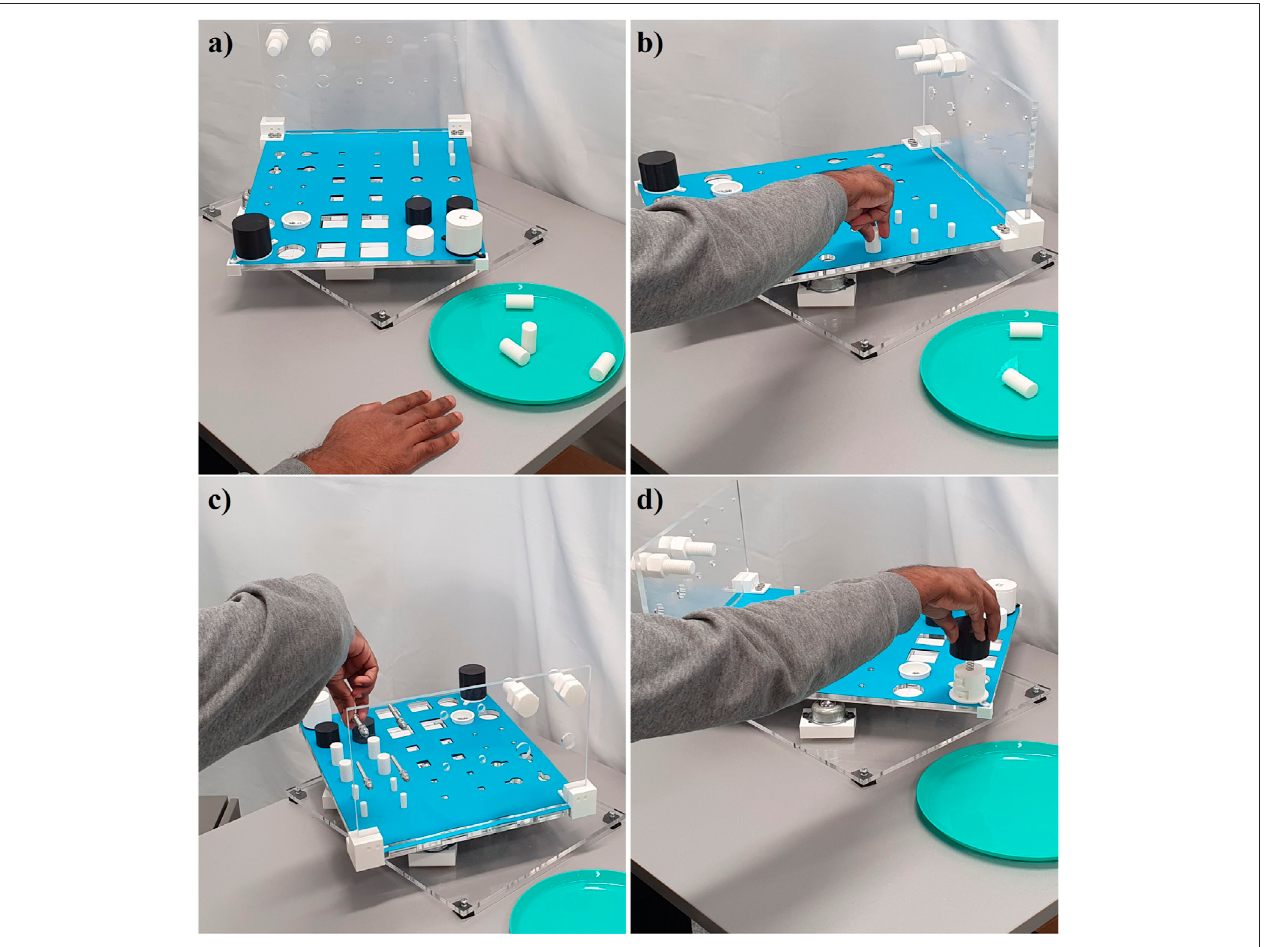
FIGURE 4 | A subject performing experiments executing tasks of the dexterity test. The sub fi gures show: (A) the initial position of the hand and objects, (B) a placingtask, (C) atool task, (D) apuzzle task. Asshown inthe images theorientationof thedexterity board constantly changesrequiring thearm-hand system toadapt to various orientations to complete the tasks